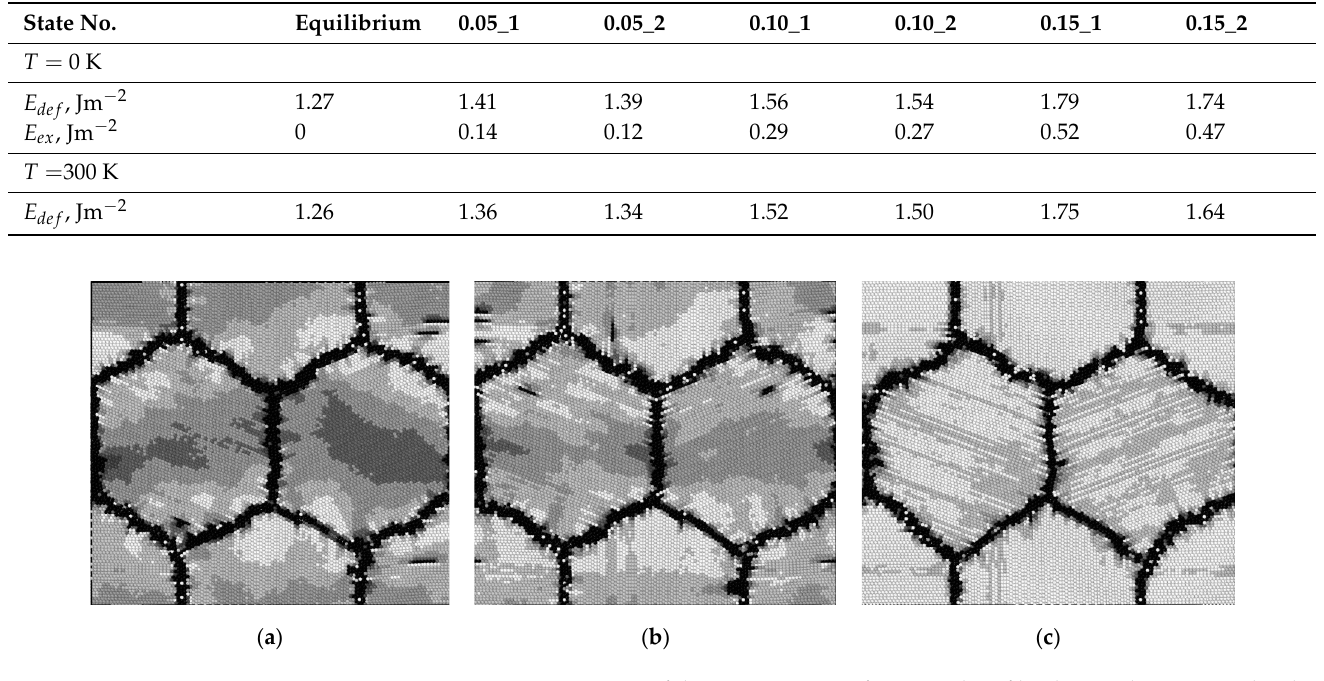
Figure 26. Atomic energy maps of the system 0.15_1 after 10 cycles of loading with stress amplitudes p 0 = 200 ( a ), 300 ( b ) and 400 MPa ( c ) at temperature of T = 300 K [121]. Table 4. Defect energies per unit GB area in nanocrystal 0.15_1 after 10 cycles of oscillating loading with different amplitudes of the stress